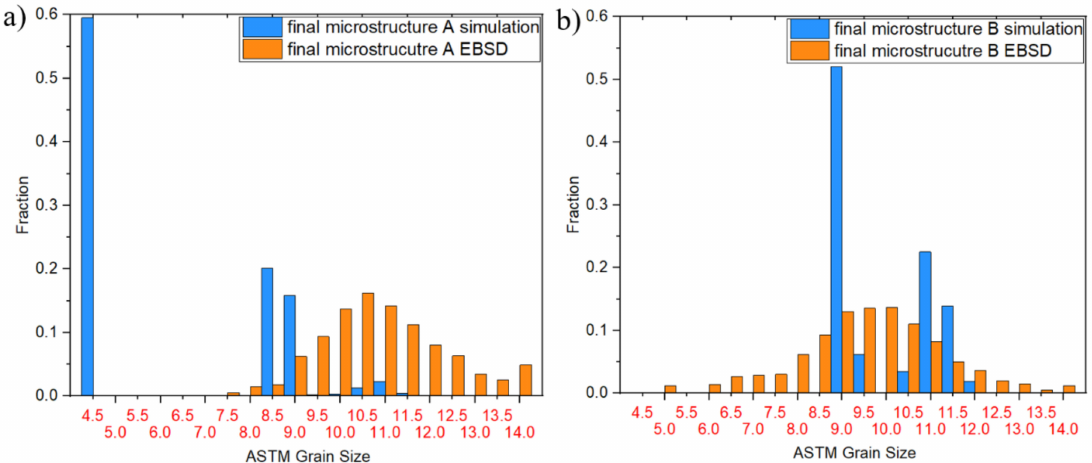
Figure 13. Grain size distribution: strain rate 1 s − 1 , strain 0.54, 15 s holding time; ( a ) microstructure A; ( b ) microstructure